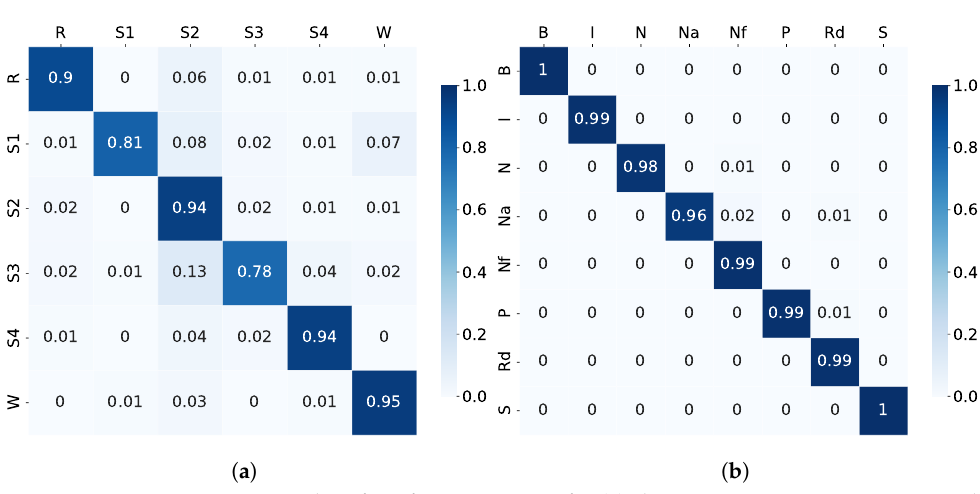
Figure 6. Experiment 2: Examples of confusion matrices for ( a ) sleep stage using MML-DMS1 with pre-trained NN and ( b ) sleep disorder detection using MML-DMS1 with trained-from-scratch